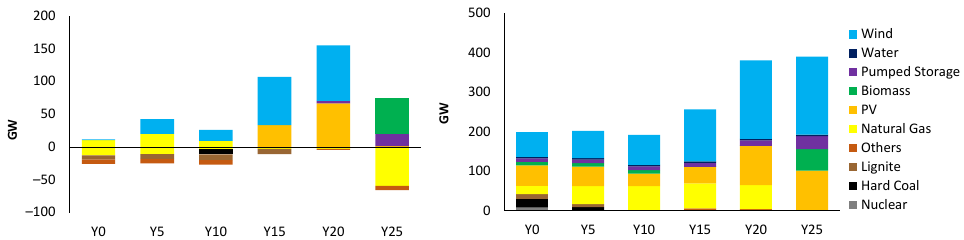
Figure 5. Endogenous capacity additions and removals ( left ) and total installed capacity ( right ) in iteration 0.